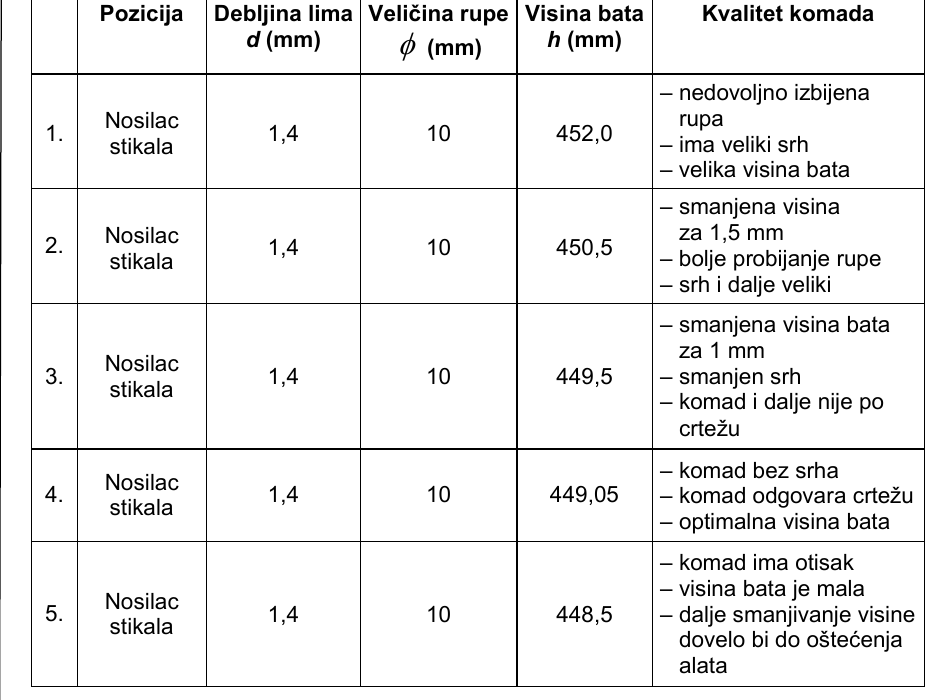
Table 4 – Experimental adjusting of the ram height for the “Nosilac stikala” position